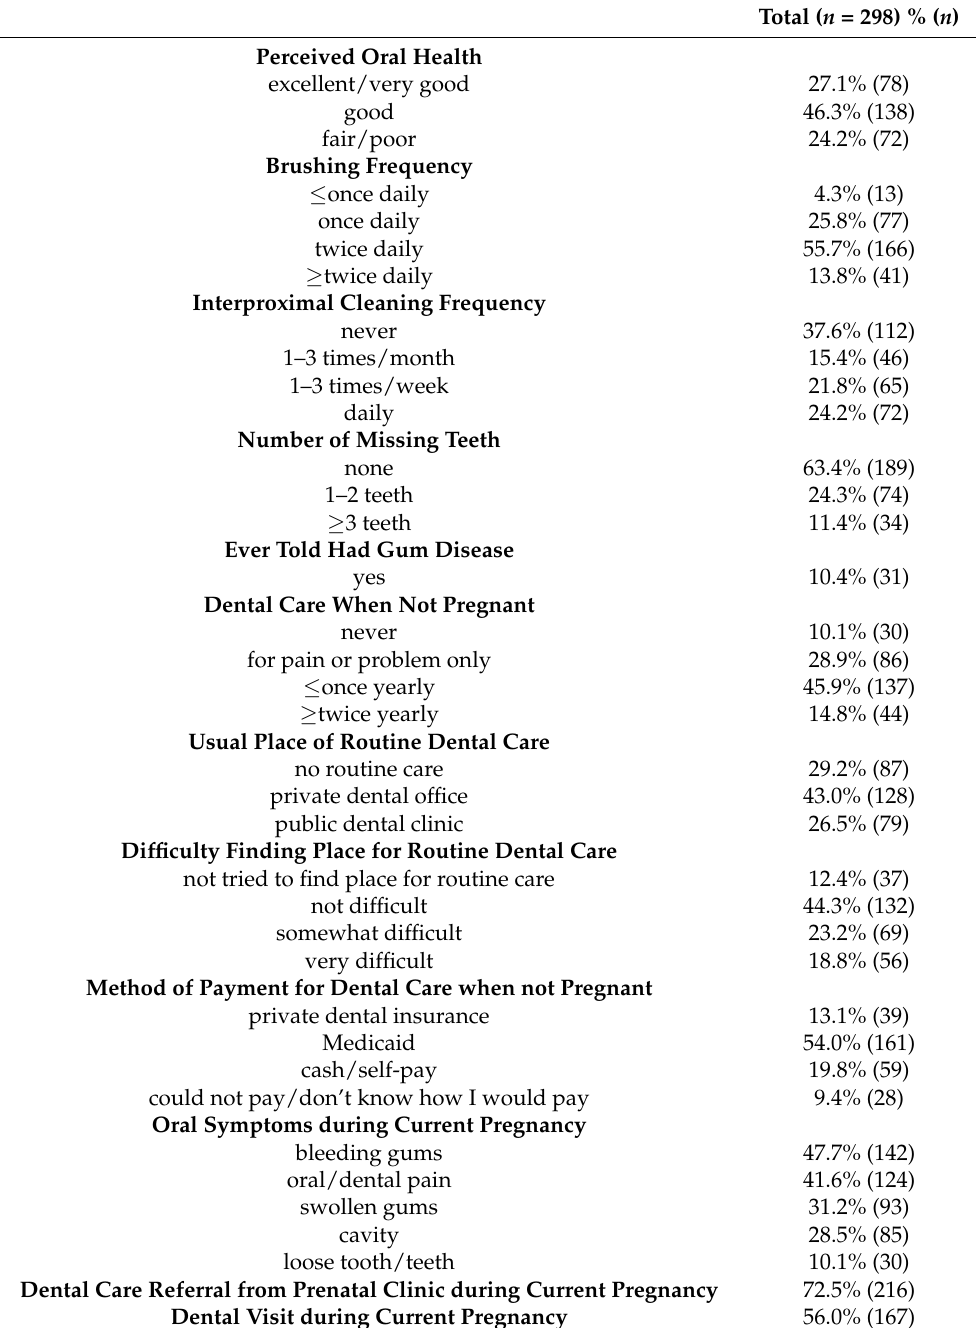
Table 2. Reported oral health/dental care characteristics of the study